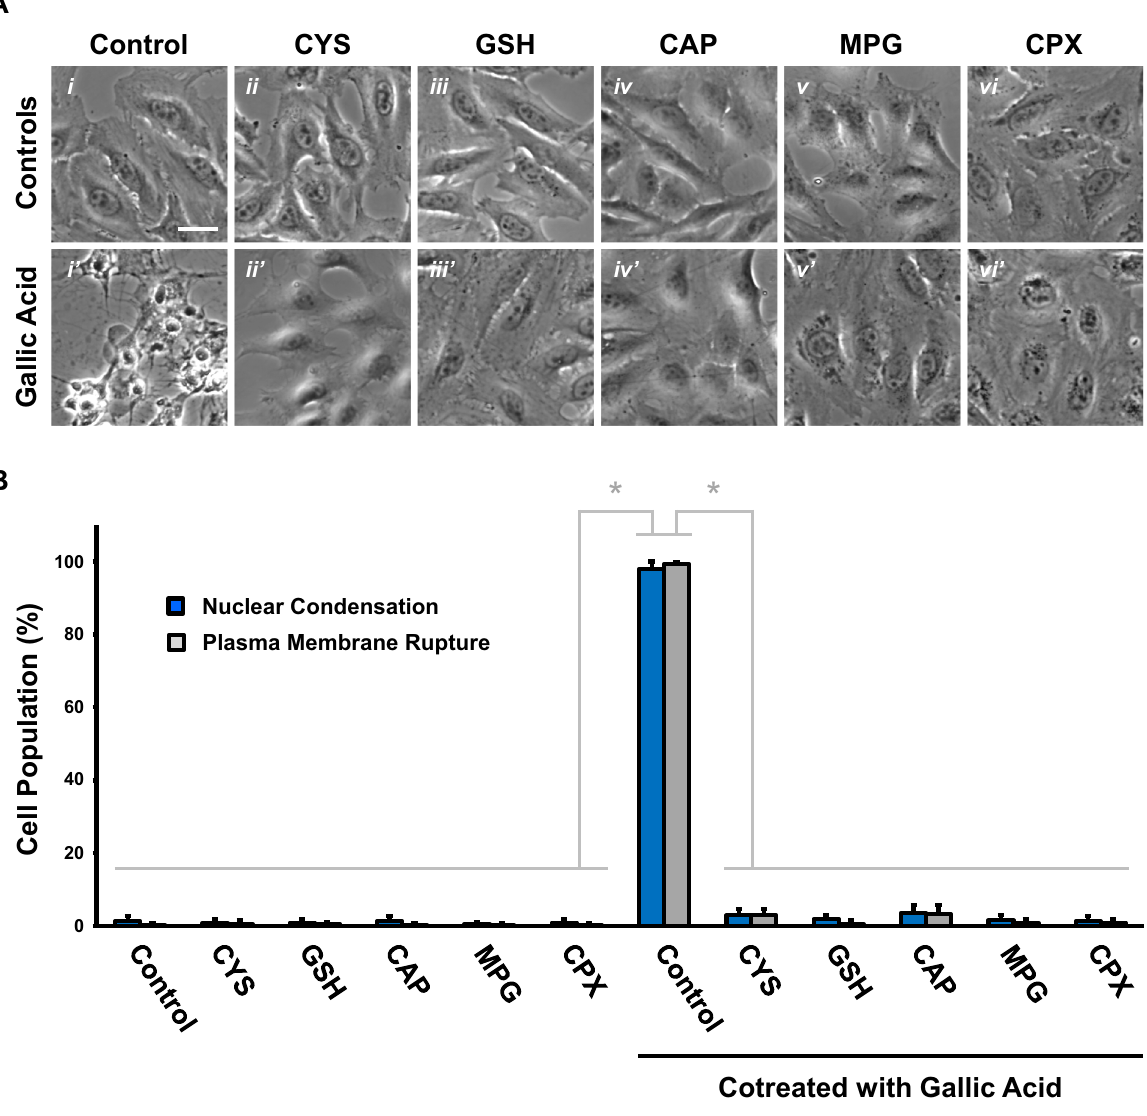
Figure 5. Inhibitors of gallic acid-induced cell death. ( A ) Phase contrast images of HeLa cells preincubated with ( i ) medium alone (Control), ( ii ) cysteine (CYS, 5 mM), ( iii ) glutathione (GSH, 10 mM), ( iv ) captopril (CAP, 10 mM), ( v ) N-(2-mercaptopropionyl)-glycine (MPG, 3 mM), or ( vi ) ciclopirox (CPX, 5 µM), for 1h and then with (lower panels, ( i ′ – vi ′ )) or without (upper panels, ( i – vi )) co-treatment of gallic acid (50 µg/mL) for 9 h. Scale bar: 30 µm. ( B ) Quantification of the cell death events, including nuclear condensation (blue) and plasma membrane rupture (grey), in HeLa cells after gallic acid induction (50 µg/mL) with or without co-treatment with compounds with the conditions listed at the panel A for 9 h. Mean ± s.d.; n = 3. The data was evaluated using one-way analysis of variance (ANOVA) followed by Tukey’s test for post-hoc analysis. * p <